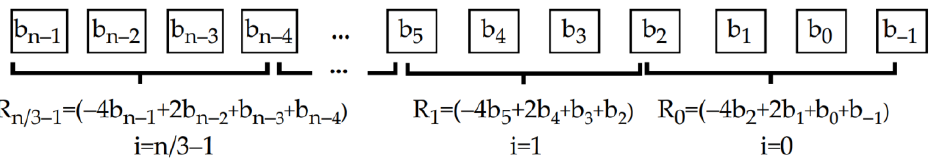
Figure 2. Integration of bits when calculating partial products for multiplication by three digits at a